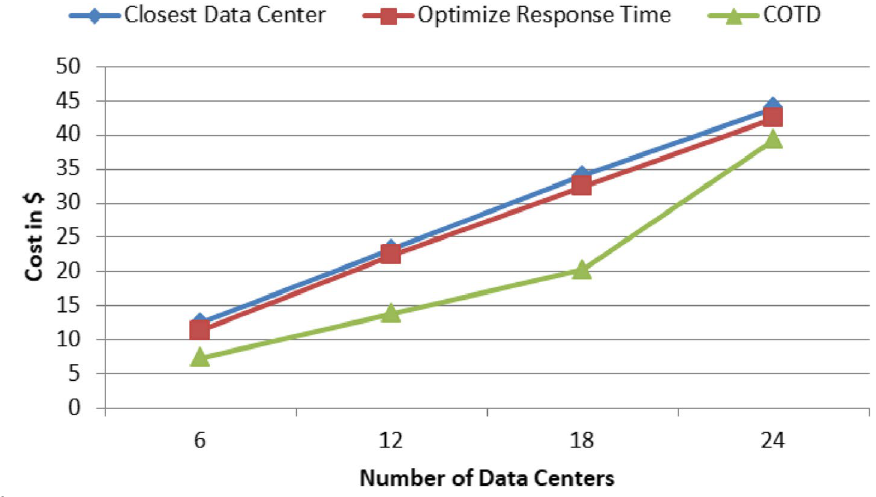
Fig. 10 Impact of COTD on cost in varying DC